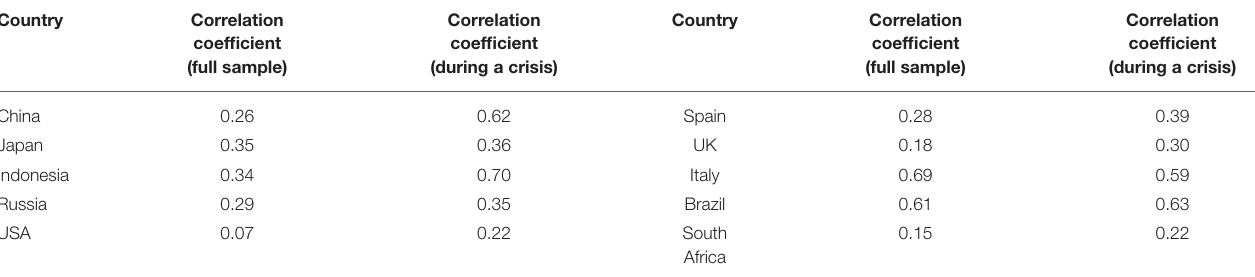
TABLE 2 | Representative national bank risk and sovereign risk correlation coefficient in full sample and during a crisis. Country